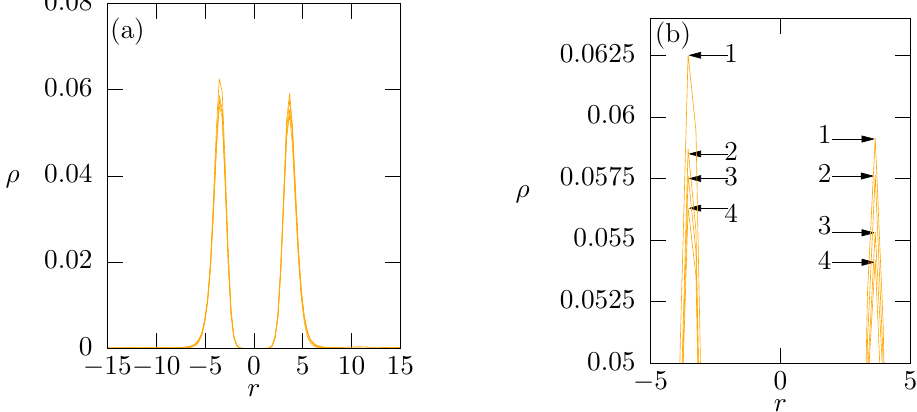
Figure 5. ( a ) Density profiles of 32 oligomer β -peptides added to the membrane; ( b ) Zoom of peaks of density profiles of oligomer β -peptides of amount of 32. Curve (1), (2), (3), (4) corresponds to 25, 50, 100, 150 Me 2 + beads